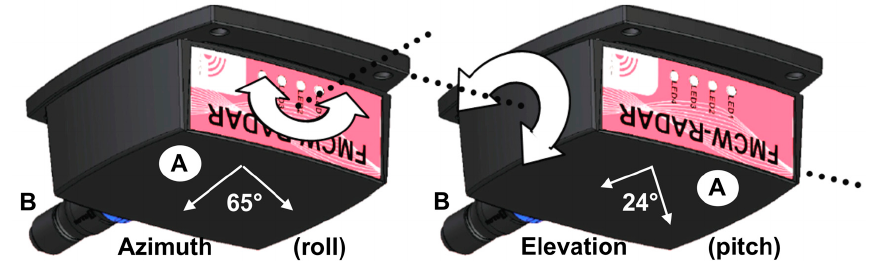
Figure 2. IMST sentire TM Radar Module. A: Radome and antenna position, B: Interface and power supply cable. At one meter above the surface, the radar footprint is about 40 cm. Table 1. Main specifications of IMST’s sentire TM Radar Module. The radar can be operated in continuous-wave (CW) radar mode (Doppler mode) or in frequency-modulated continuous-wave (FMCW) radar mode (see IMST [51] user guide for details).